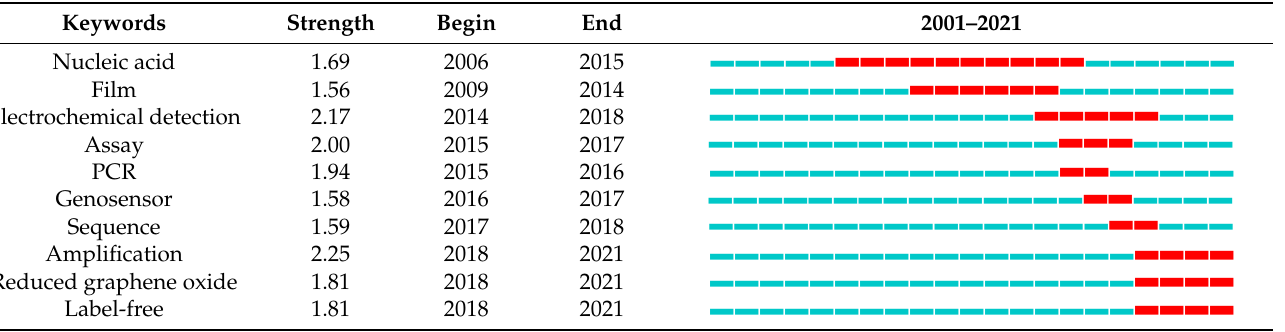
Table 4. The 10 keywords with the strongest citation bursts during the research history of the elec- trochemical techniques for the detection and analysis of GM crops.